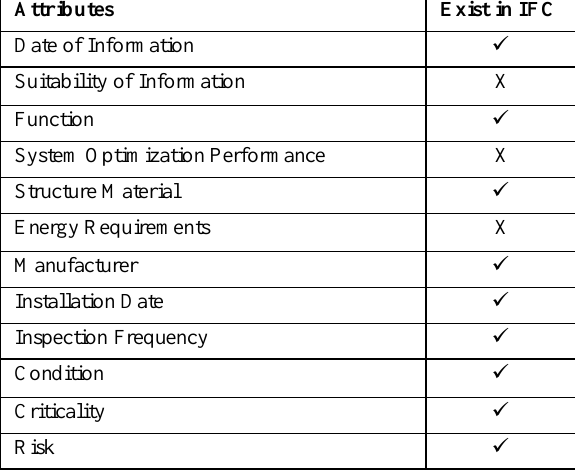
Table 2: Comparison of Asset Management properties with existing property sets in IFC